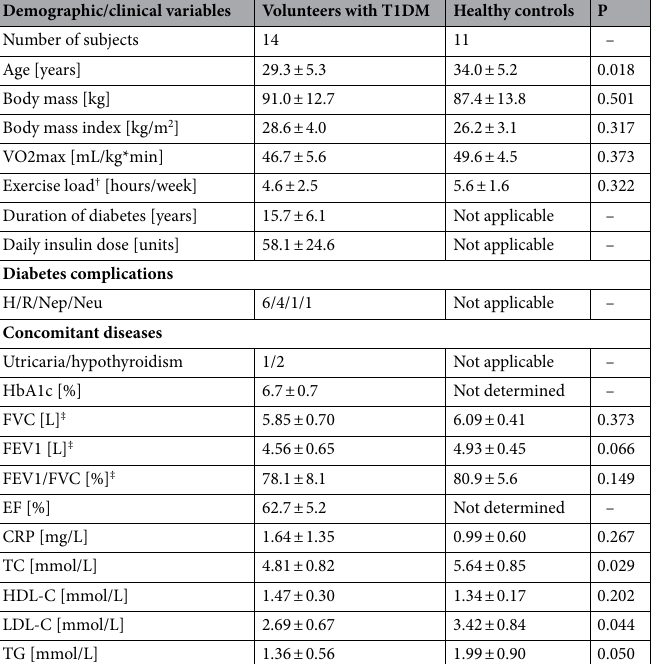
Parameter Run distance to exhaustion